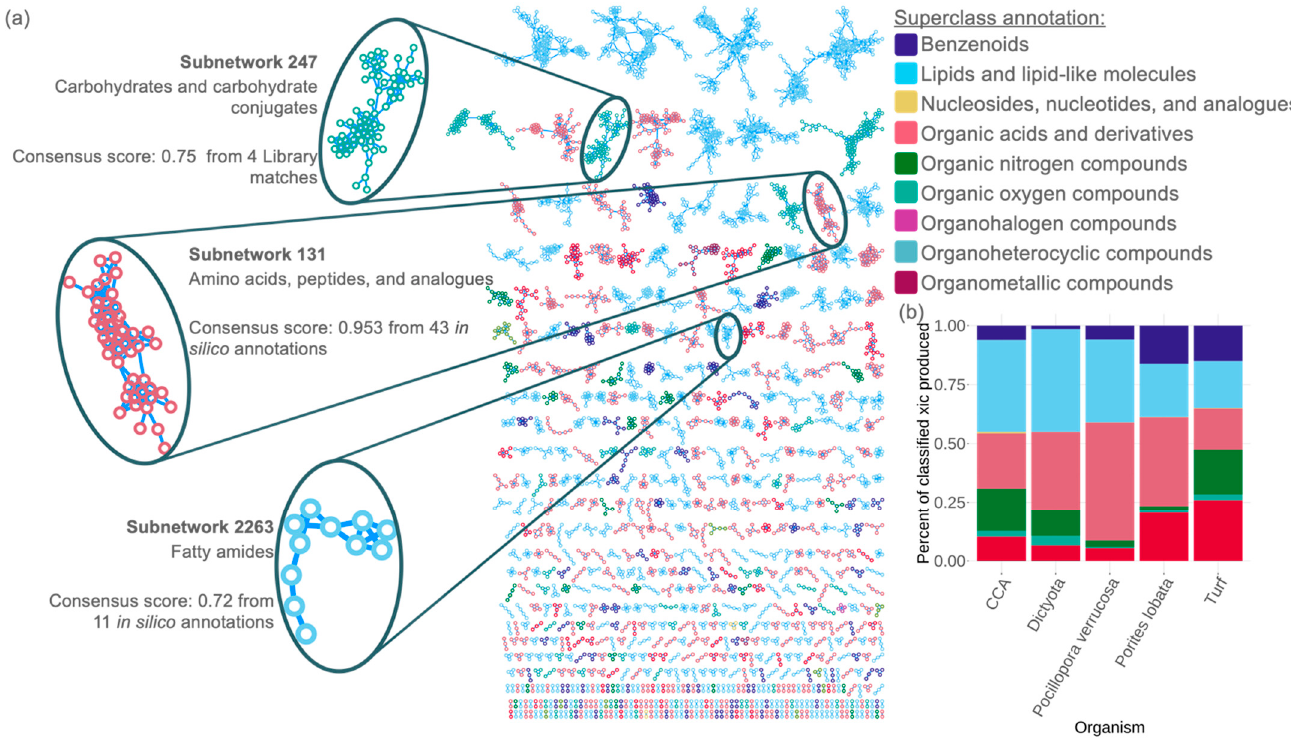
Figure 3. Putative identification of exometabolites released by coral reef primary producers. Dissolved organic matter chemo-diversity from flow-through organism incubations in Mo’orea, French Polynesia of crustose coralline algae (CCA), Dictyota ceylanica , turf algae, Pocillopora verrucosa, and Porites lobata . ( a ) The molecular network of ConCISE classified subnetworks from the incubations with nodes colored by superclass annotation. Three representative subnetworks have been highlighted to illustrate the narrower chemical classification which can be derived from ConCISE annotations along with the consensus score for the annotation within the molecular network. ( b ) Stacked bar chart illustrating the percent of classified extracted ion chromatogram (xic) which falls into each superclassification from each organismal incubation.